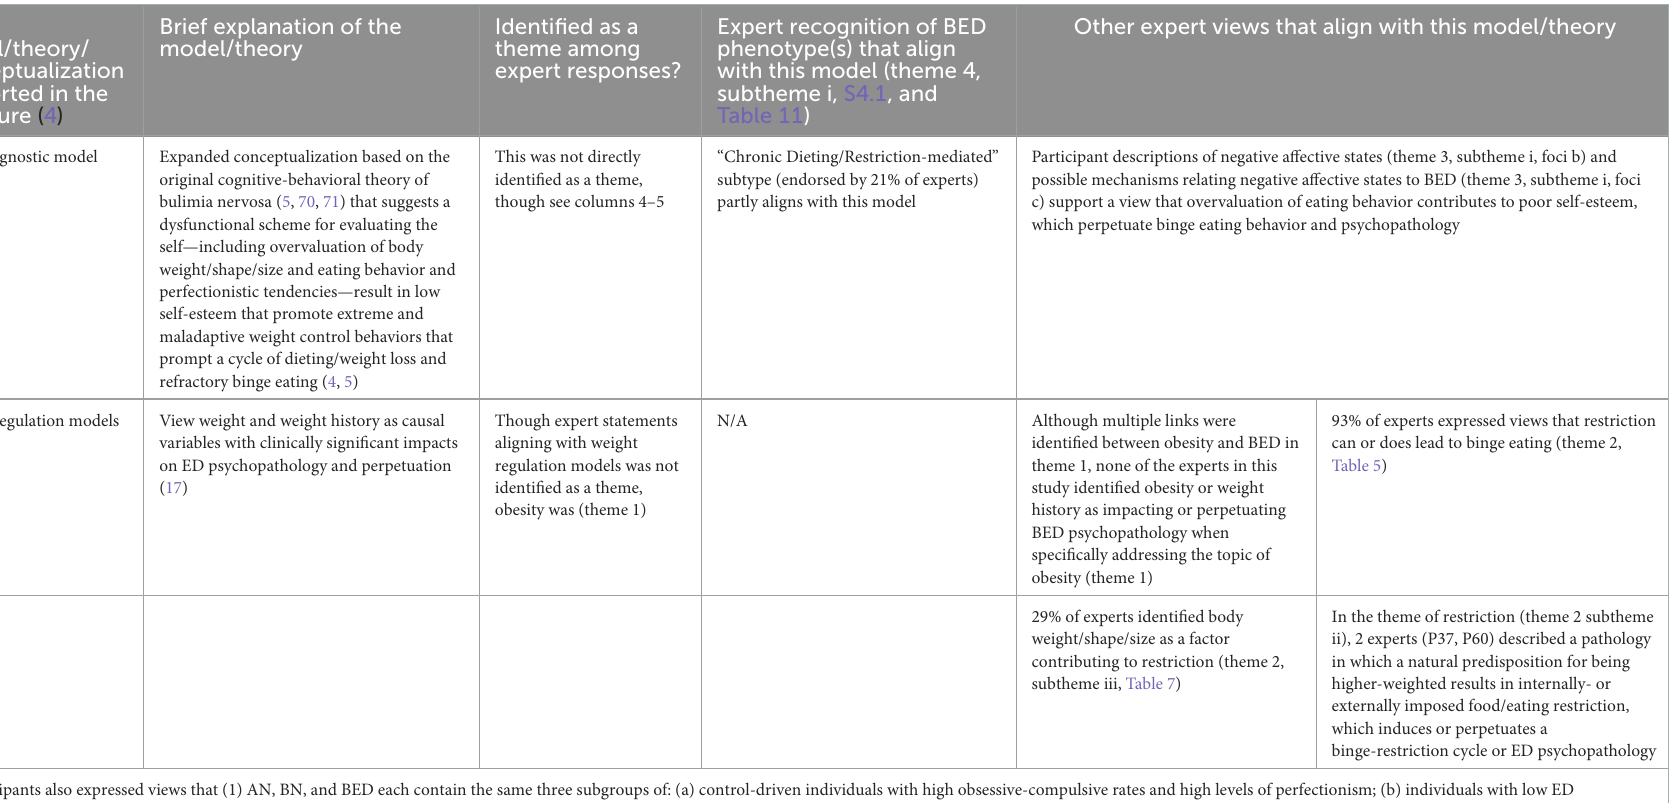
Other expert views that align with this model/theory